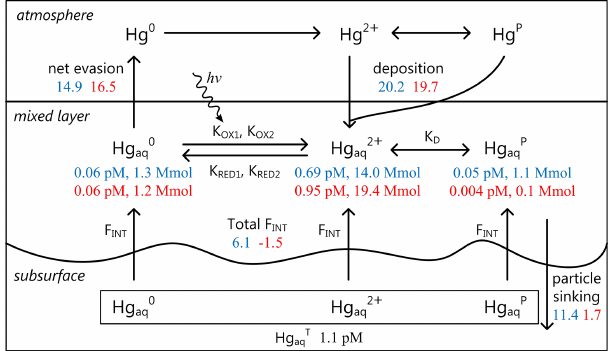
Figure 6. Global ocean mercury budget modeled by GEOS-Chem. Blue color indicates the reference simulation and red color the pa- rameter inversion. Fluxes are in megamoles per year. Notations in this figure follow Soerensen et al. (2010b). F INT denotes net fluxes from subsurface waters through entrainment/detrainment of the mixed layer and Ekman